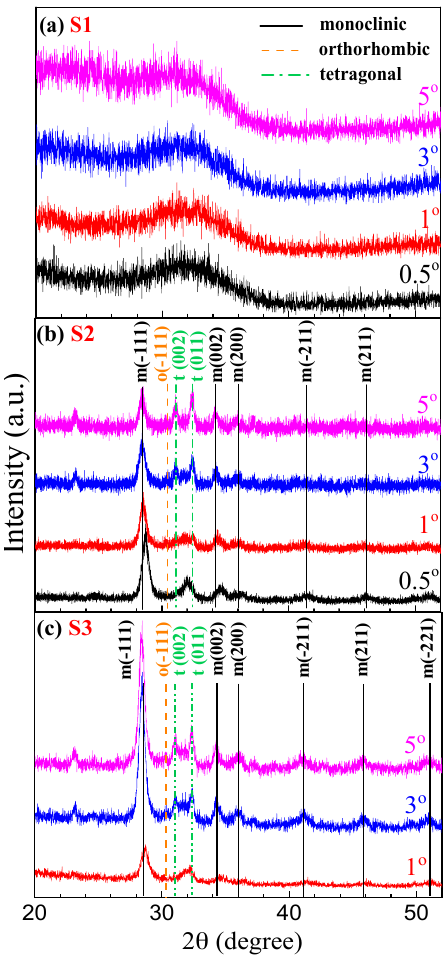
Figure 6. Grazing incidence X-ray diffraction (GIXRD) patterns of S1, S2 and S3 with different incident angles (0.5°, 1°, 3° and 5°) are shown in ( a – c ), respectively.